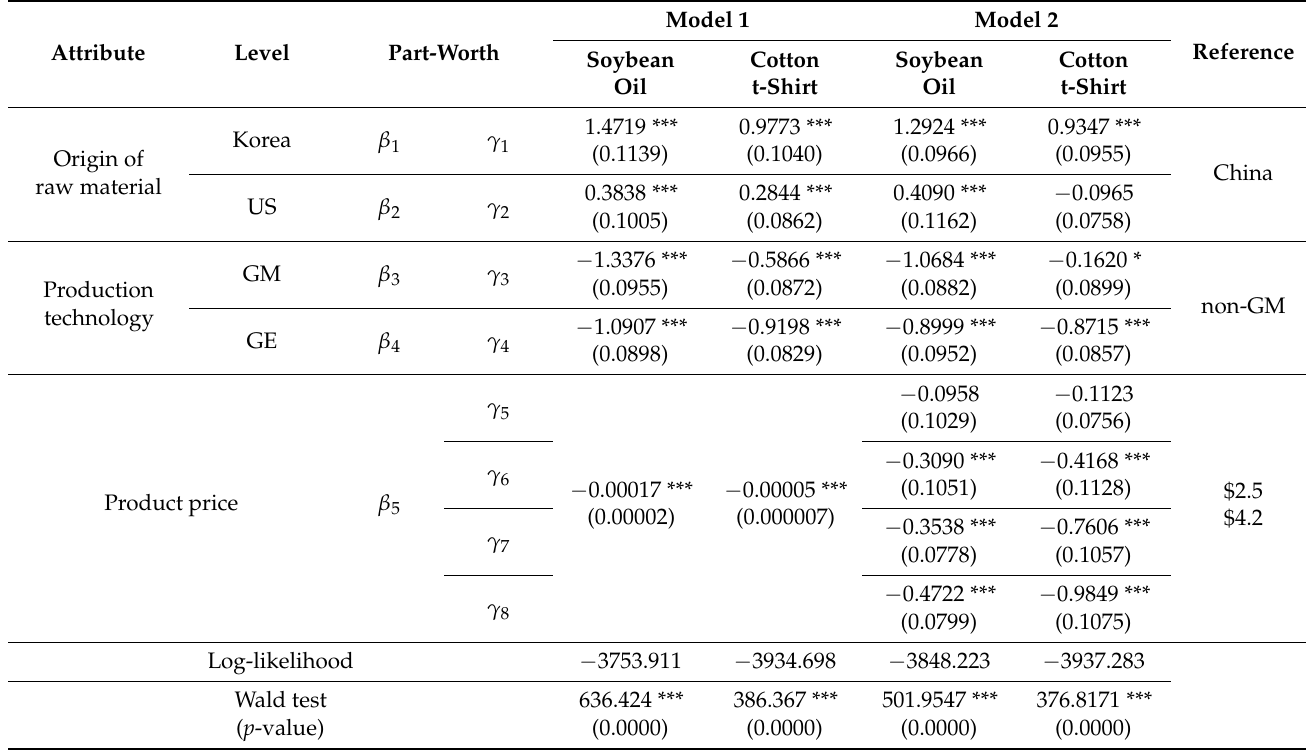
Table 6. Part-worth by an attribute level.